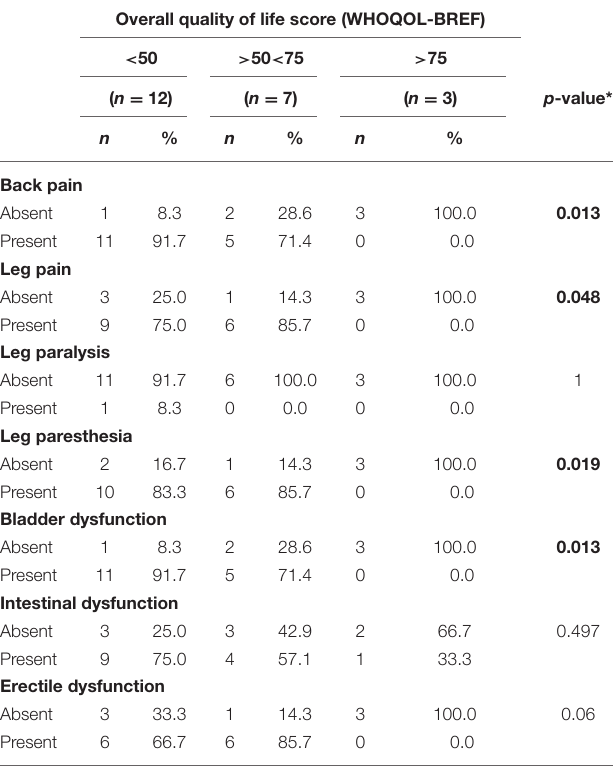
TABLE 5 | Analysis of overall quality of life score and clinical complications of schistosomal myeloradiculopathy. Overall quality of life score